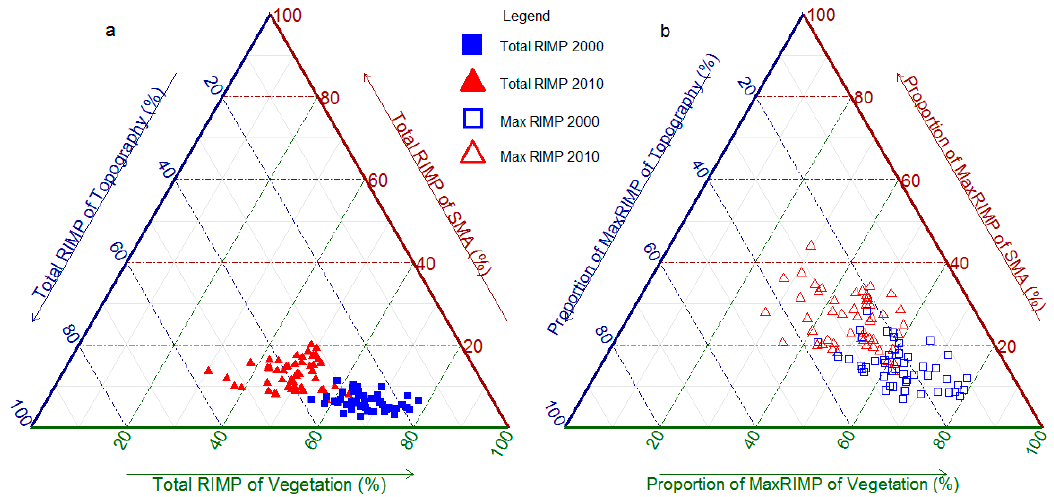
Figure 6. Ternary plot ( a ) showing the total relative importance proportion (RIMP) of three groups of explanatory variables (i.e., Vegetation, Topography and Surface Moisture Availability (SMA)) in controlling fire severity of 2000 (blue) and 2010 (red). In considering the difference of variable numbers among three groups, a variable which has the maximum RIMP (MaxRIMP) of each group is selected and compared ( b ). Axis in ternary plot ( b ) representing relative proportions of MaxRIMP for three types of variables.